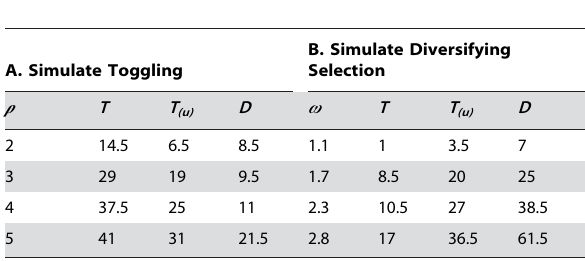
Table 1. Power (%) to detect selection with alternative models.